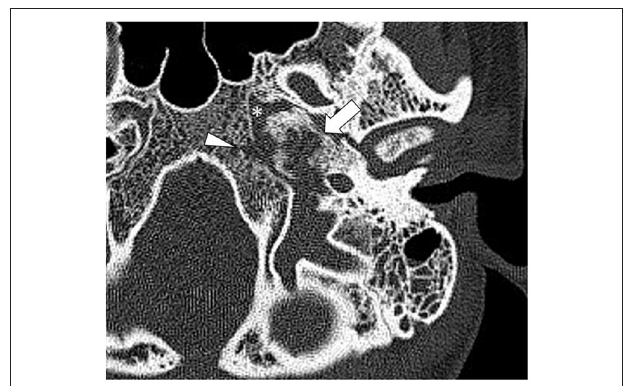
FIGURE 1 | Axial high-resolution computed tomography (HRCT) of the skull base shows a destructive process in the petrous apex (arrow) with regional sclerosis involving the petroclival fissure (asterisk) and clivus (arrowhead).